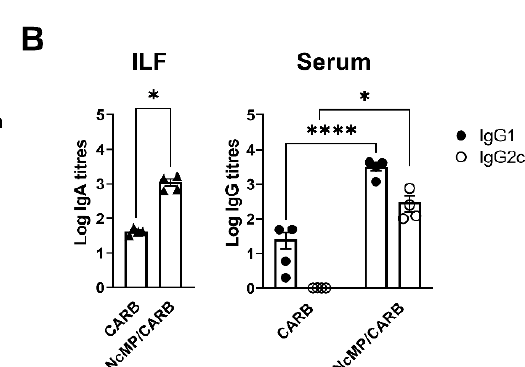
Figure 3. Analysis of N. caninum -specific antibodies. Timeline of immunization and sample